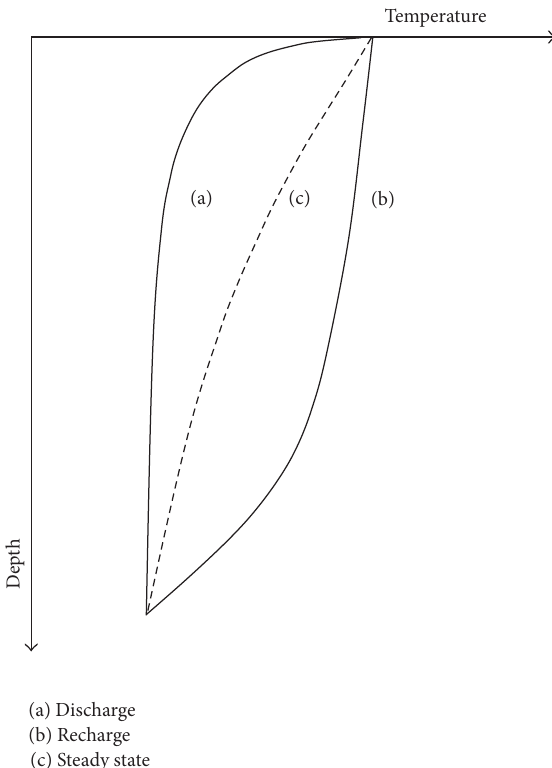
Figure 4: The simplified schematic diagram to determine the water exchange patterns.